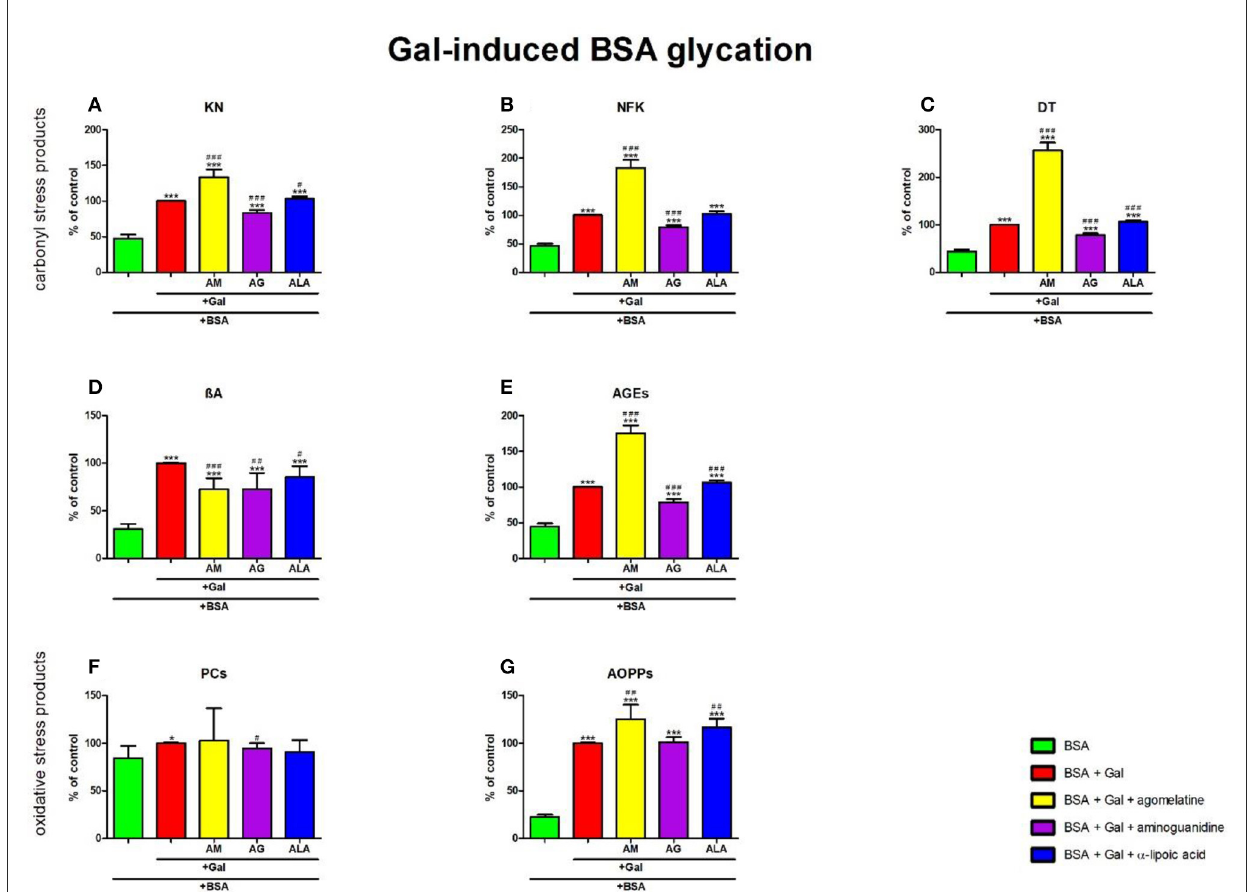
FIGURE7 Effects of agomelatine addition to galactose (Gal)-glycated bovine serum albumin (BSA) on carbonyl stress products (A–E) and oxidative stress products (F, G) . AG, aminoguanidine; AGEs, advanced glycation end products; ALA, α -lipoic acid; AM, agomelatine; AOPPs, advanced oxidation protein products; β A, β -amyloid; BSA, bovine serum albumin; DT, dityrosine; Gal, galactose; KN, kynurenine; NFK, N-formylkynurenine; PCs, protein carbonyls. * p < 0.05 vs. negative control (BSA); ** p < 0.01 vs. negative control (BSA); *** p < 0.001 vs. negative control (BSA); # p < 0.05 vs. positive control (BSA + Gal); ## p < 0.01 vs. positive control (BSA + Gal); ### p < 0.001 vs. positive control (BSA +